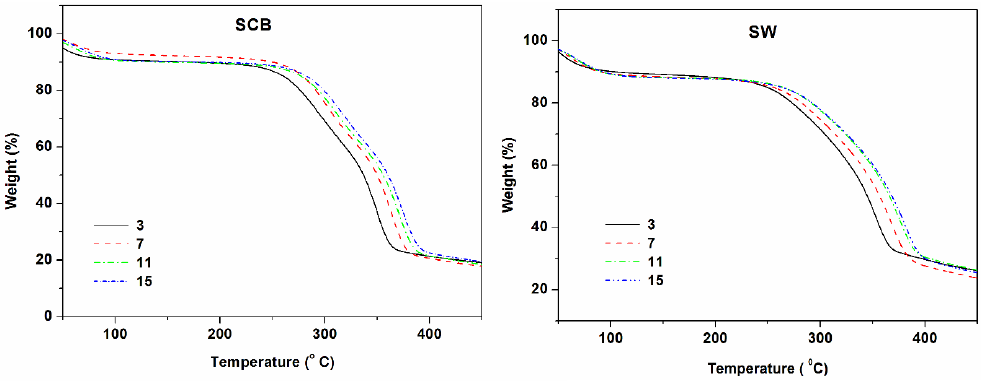
Figure 4. TGA graphs of SCB and SW at different rates